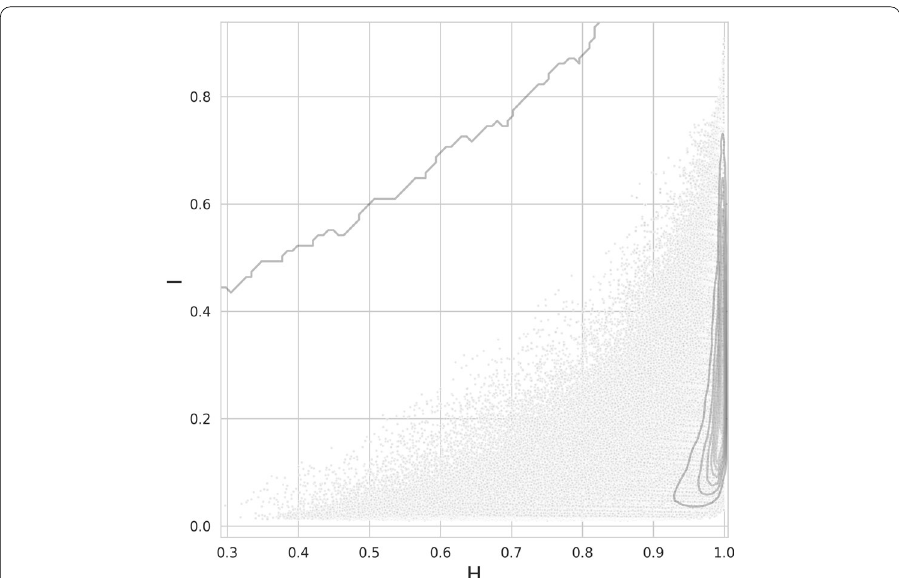
Fig. 22 Homogeneity and intensity H × I results on 1,329,696 synthetic multiplex networks considering their combined elementary layers and transition coupling with density lines (Gaussian kernel density